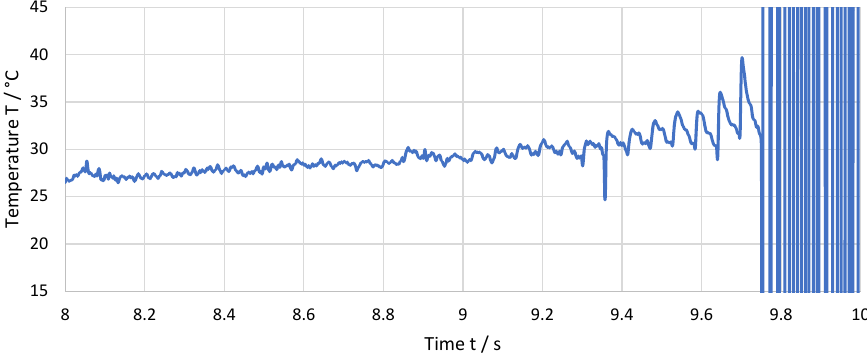
Figure 8. Measured temperature over the last 2 seconds before the destruction of the thermocouple for a feed of f = 36 µm. The non-computed measurement data as recorded during the experiment as well as spectral analysis data of Figures 7 and 8 are available as Supplementary Material S3 and S4, respectively.